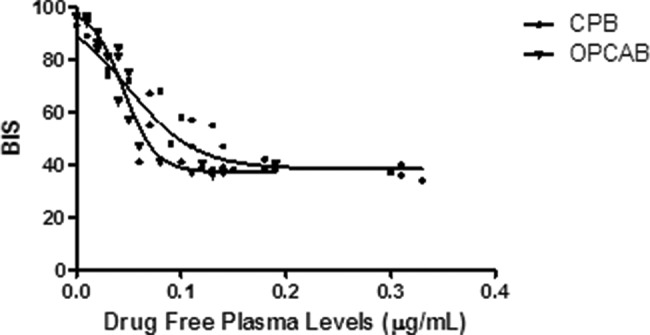
PK/PD analysis based on the sigmoid EMAX model in the CPB-H group compared to the OPCAB group. The sigmoid shape was generated using the medians. BIS axis: Y0=85 in the CPB-H group versus Y0=95 in the OPCAB group at orotracheal extubation; EC50=1.12, r2>0.90. Abbreviations – BIS: bispectral index; CPB: on-pump coronary artery bypass grafting; OPCAB: off-pump coronary artery bypass grafting.